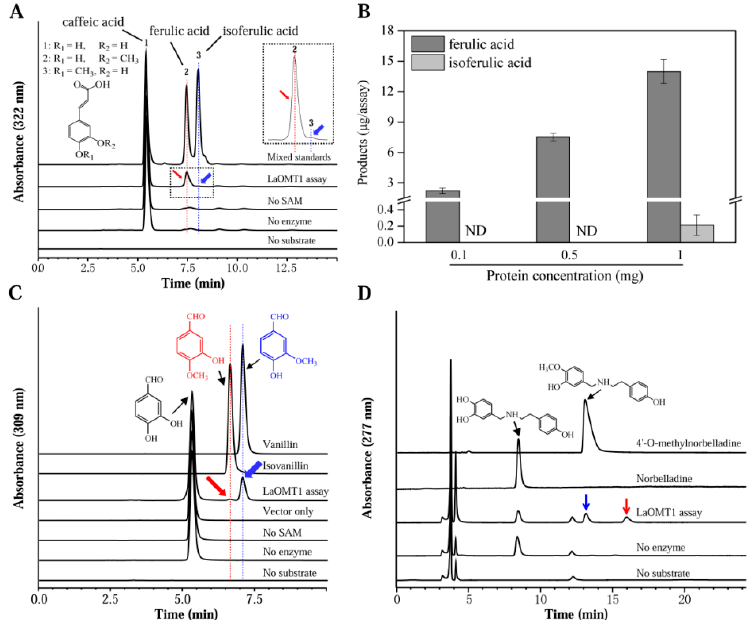
Figure 2. Assays of LaOMT1 enzyme activity in vitro for different substrates. ( A ) HPLC analysis of cafferic acid (1) incubated with the recombinant LaOMT1 protein. Two new peaks representing ferulic acid (2) and isoferulic acid (3) were verified, according to each identical retention time. ( B ) A dose-dependent activity of LaOMT1 when 1 mM caffeic acid incubated with the recombinant LaOMT1 enzyme in different concentrations. Each dataset represents the mean ± standard deviation (SD) from triplicate measurements. ( C ) HPLC analysis of 3,4-dihydroxybenzaldehyde incubated with the recombinant LaOMT1 protein, where two new peaks with the same retention time as isovanillin (red arrow) and vanillin (blue arrow) were found. ( D ) HPLC analysis of norbelladine incubated with the recombinant LaOMT1 protein. The two new products were indicated with blue arrow and red arrow,